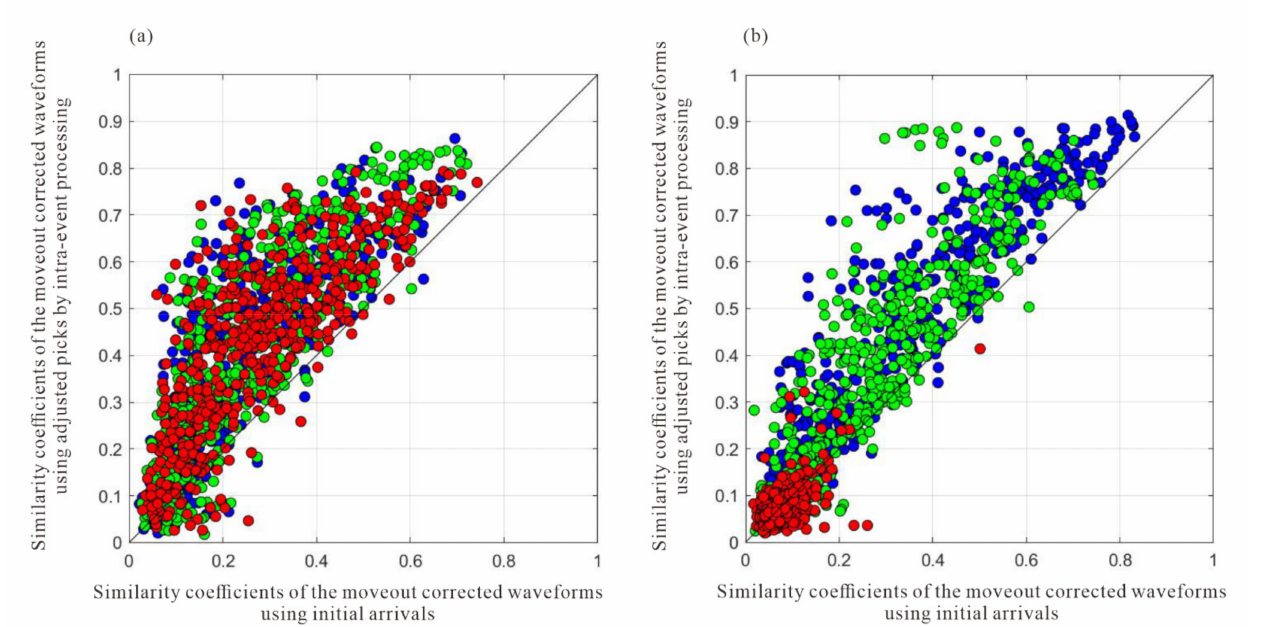
Figure 16. The similarity coefficients of moveout corrected waveforms before and after intra-event arrival refinement. ( a ) P wave; ( b ) S wave. Blue, green, and red circles represent x-, y-, and z- components